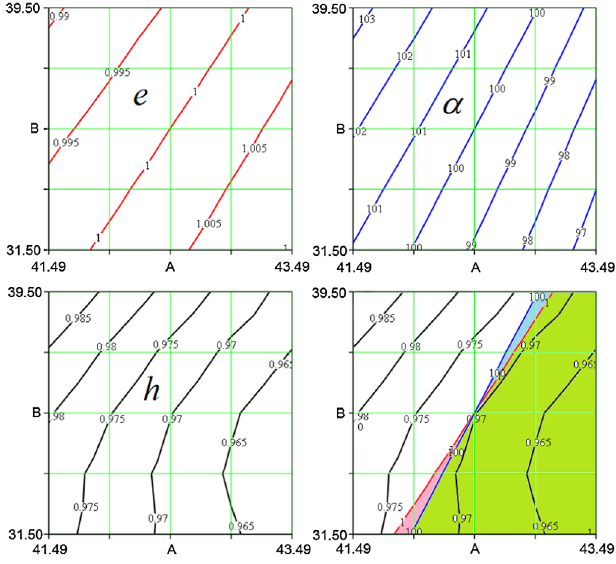
FIG. 9. Map for the optimized TESLA cavity. a ¼ 12 . 13 mm, b ¼ 19 . 70 mm, β ¼ 1